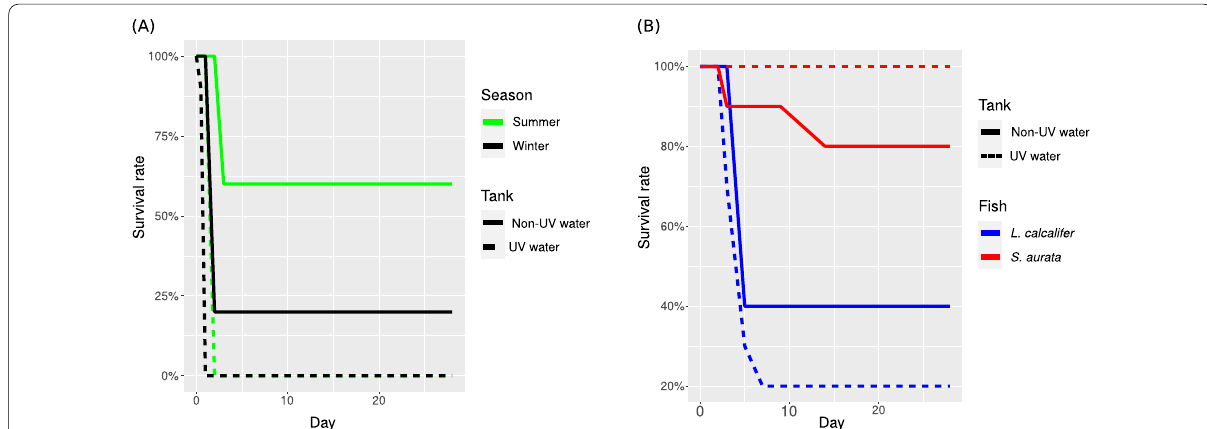
Fig. 1 Survival rate in percentage over 30 days post infection of S. aurata after V. harveyi infection in summer 2015 and winter 2016 ( A ) and for Both L. calcarifer and S. aurata fish species after S. iniae infection in 2020, winter season ( B